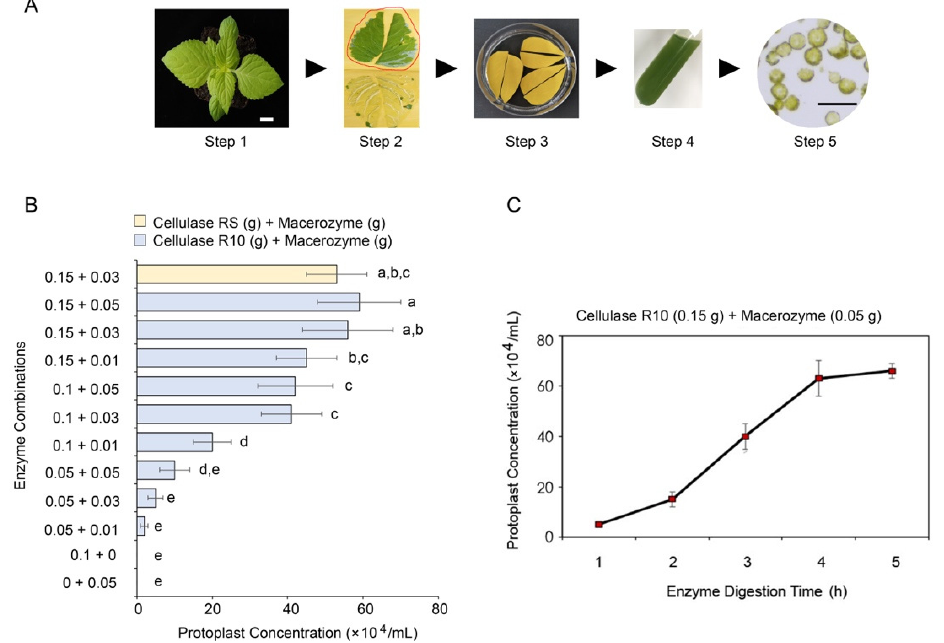
Figure 1. Isolation of T. fournieri protoplast using different combinations of enzymes and conditions. ( A ) Overview of the experimental procedure of torenia protoplast isolation. Step 1: Preparation of 45–60-day-old torenia plants with healthy and fully expanded leaves. Scale bar = 1 cm. Step 2: Re- moval of the lower epidermis of torenia leaf with adhesive tape. Step 3: Submerging the leaves on adhesive tape into the enzyme solution with the abaxial surface facing downward. Step 4: Resus- pension of the protoplast in the W5 solution. Step 5: Microscopic examination of the quality of the protoplasts. Scale bar = 50 μ m. ( B ) The effect of different enzyme combinations on the efficiency of torenia protoplast isolation. Significant analysis was performed by ANOVA followed by Tukey post hoc test ( p < 0.05). Error bars indicate the standard deviations of eight biological replicates. ( C ) The effect of enzyme digestion time on the torenia protoplast isolation. Error bars indicate the standard deviations of eight biological replicates.